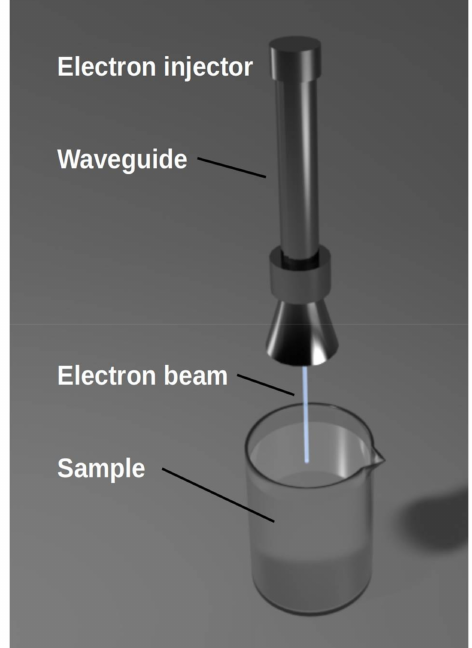
Figure 4. Electron beam function against